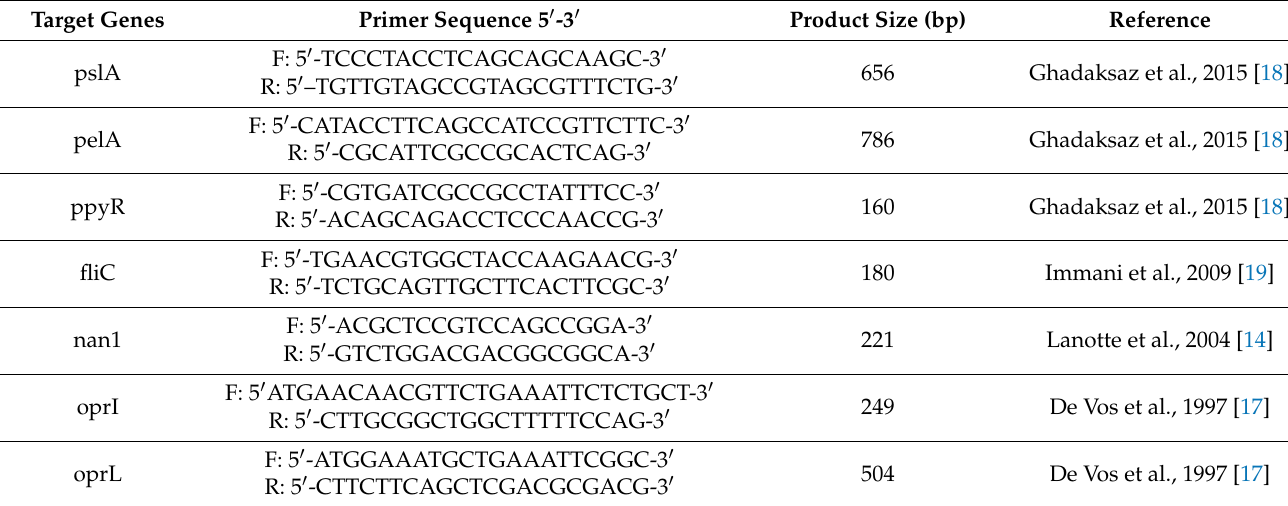
Table 2. PCR assay reaction conditions and primers used in this